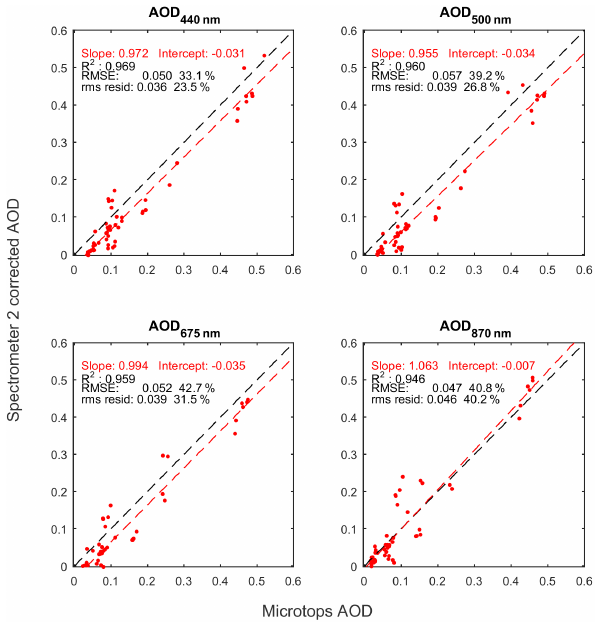
Figure 15. Comparison of Spectrometer 2 (Zeiss) and Microtops AOD measurements at four wavelengths over the AMT